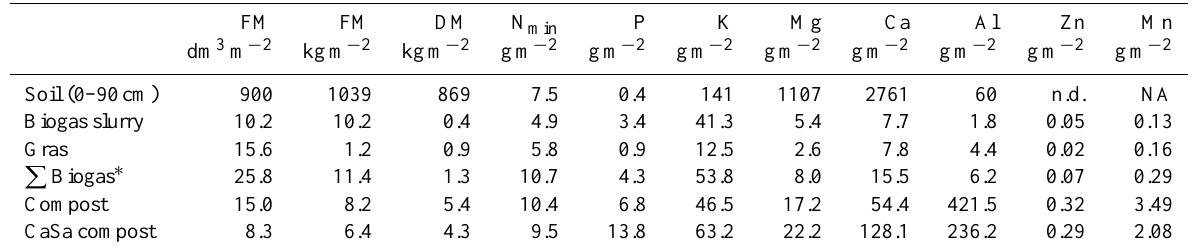
Table 3. Soil nutrient status before applying the amendments and the nutrient loads of the amendments.